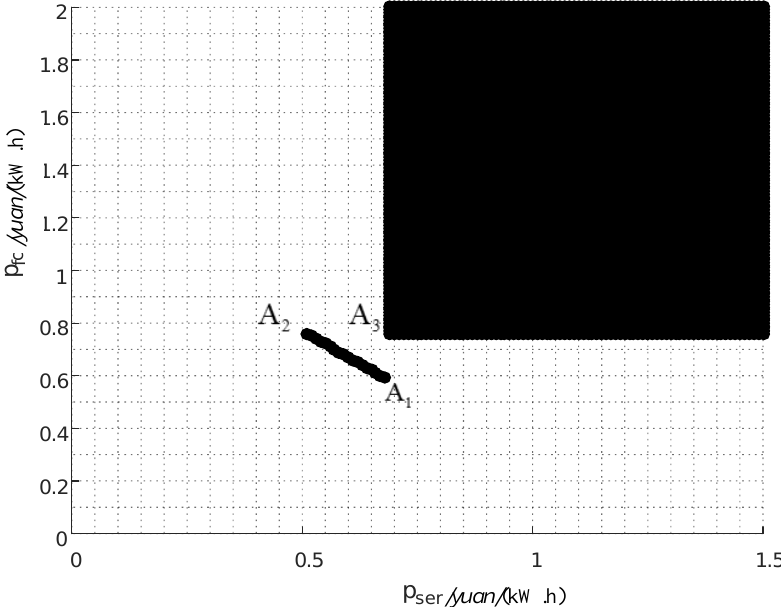
Figure 5. Two-party sketch of the game Nash equilibria.